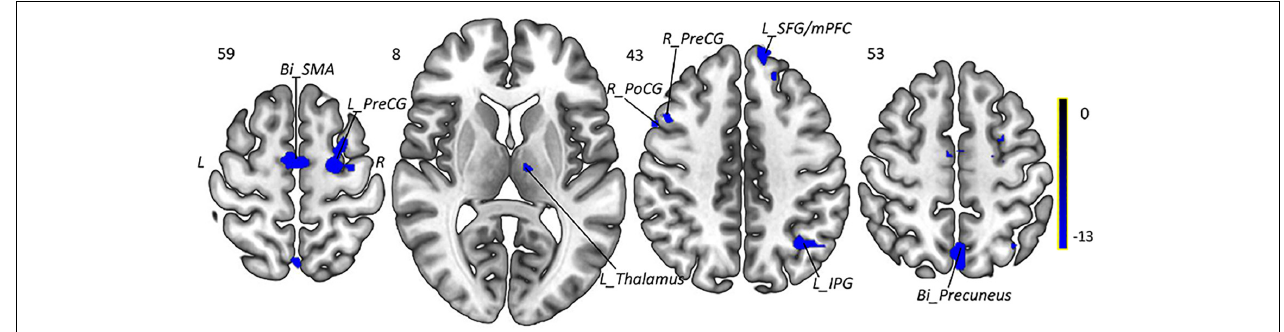
FIGURE 5 | Intragroup comparison of fALFF in patients with MWoA after 4-week treatment. Compared with pretreatment MWoA patients, migraineurs receiving 4-week taVNS treatment showed decreased fALFF in the left thalamus, bilateral PreCG, right PoCG, bilateral SMA, left IPG, bilateral precuneus, and left SFG/mPFC, but no significantly increased brain regions. Blue colors indicate regions with decreased fALFF. Bi, bilateral; R, right; L, left; PoCG, postcentral gyrus; PreCG, precentral gyrus; SMA, supplementary motor areas; SFG, superior frontal gyrus; mPFC, medial prefrontal cortex; IPG, inferior parietal gyrus.